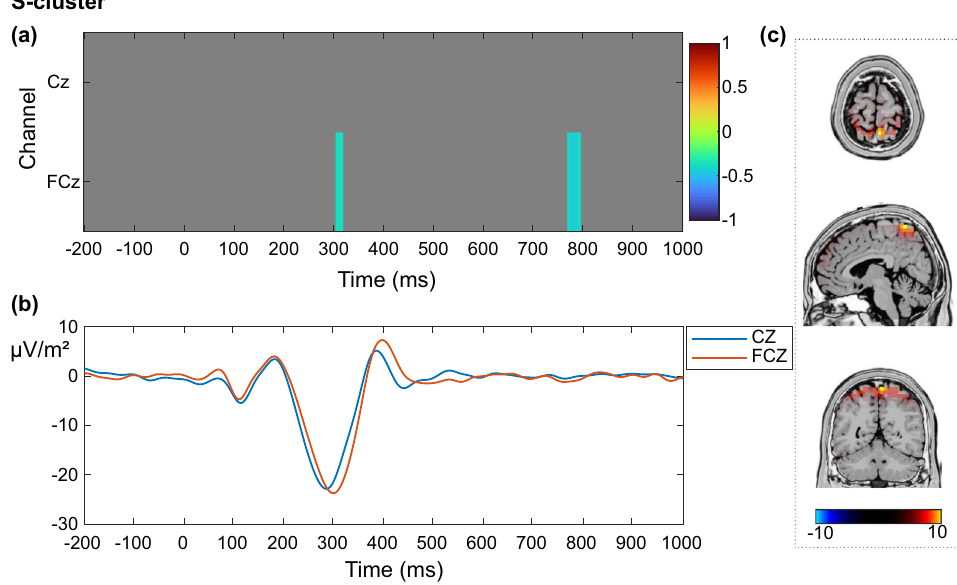
Figure 2. Correlation between resting theta activity and decomposed event-related potentials (ERPs) during correctly rejected Nogo trials in the S-cluster. ( a ) Correlation between resting theta activity and each time point of the EEG signal in the S-cluster from 200 ms before stimulus onset to 1000 ms after stimulus onset for the electrodes Cz and FCz. Only significant correlations with p ≤ .05 after a channel-by-channel correction with the false discovery rate method are shown. The correlation coefficient r is indicated by color. ( b ) Grand average of the participants’ ERPs in the S-cluster for the electrodes Cz (blue) and FCz (orange) from 200 ms before stimulus onset to 1000 ms after the stimulus onset. ( c ) sLORETA plots depicting activation differences in the superior parietal cortex (BA7) after contrasting the Nogo condition (correct rejections) in the S-cluster against zero. The color bar shows the critical t -values ( p < .05, corrected for multiple